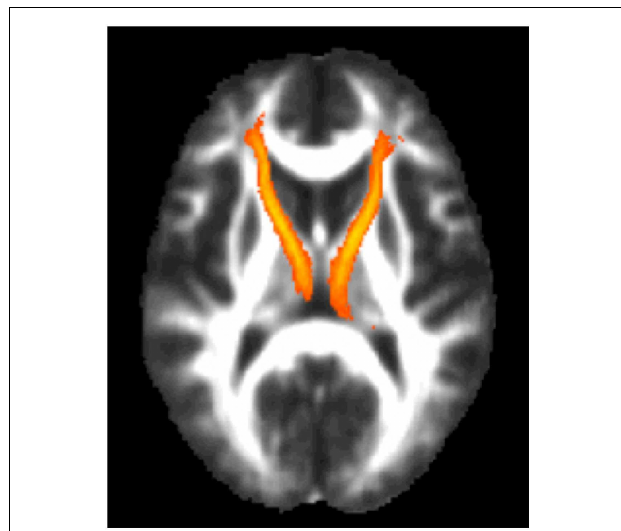
FIGURE 2 |The region of interest/mask of the bilateral anterior thalamic radiations shown in yellow-orange superimposed on the group mean fractional anisotropy image for the entire cohort .The region of interest/mask was thresholded to a 75% probability of being within the actual anterior thalamic